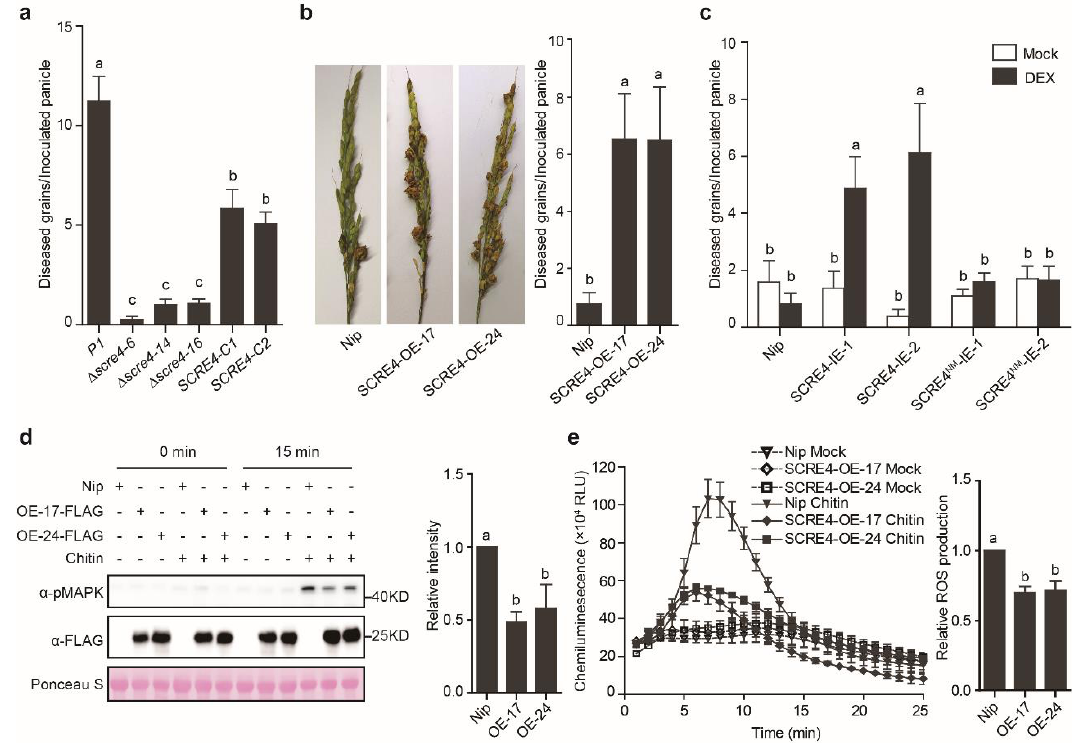
Figure 2. SCRE4 is an essential virulent factor in U. virens . ( a ) The average number of diseased grains per inoculated panicle. The U. virens wild − type (P1), scre4 knockout mutant and complemented strains ( SCRE4 − C1 and C2 ) were injection-inoculated into young panicles of the susceptible rice cultivar LYP9 ( n = 14, 15, 15, 15, 12, 13). ( b ) Disease symptoms and diseased grains on rice panicles of the wild − type (Nip), SCRE4 − OE − 17 and − 24 lines after inoculation of the U. virens isolate JS60 − 2 ( n = 12, 13, 10). Left images showed disease symptoms on the representative rice panicles after U. virens inoculation. ( c ) Diseased grains on U. virens − inoculated panicles of the wild − type (Nip), SCRE4 − IE and SCRE4 NM − IE lines. The wild − type and different transgenic lines were treated with 30 µM DEX and mock solution followed by injection inoculation with JS60 − 2 ( n = 12, 11, 8, 8, 8, 8, 10, 10, 10, 9). In panels ( a – c ), diseased grains were counted at 4 weeks after inoculation. The representative data from three independent experiments are shown as mean ± SE. Different letters ( a – c ) indicate significant differences in the average number of diseased grains on rice panicles after inoculation of different strains ( a ), on the panicles of the wild − type and SCRE4 − OE transgenic lines ( b ), and on the SCRE4 − IE panicles after DEX and mock treatments ( c ) ( p < 0.05, Duncan’s multiple range test) . ( d ) Chitin − triggered MAPK activation in the wild − type and SCRE4 − overexpressing transgenic lines. Total protein loading is indicated by Ponceau S staining. Right panel, the chitin − activated MAPK phosphorylation levels normalized to total proteins from three independent experiments are shown as mean ± SE ( n = 3). Band intensity was determined by densitometry using ImageJ. Different letters ( a vs. b ) indicate a significant difference in the MAPK phosphorylation level ( p < 0.05, Duncan’s multiple range test). ( e ) Chitin − triggered ROS burst in the wild − type and SCRE4 − overexpressing transgenic lines. Right panel, relative ROS production in Nipponbare and SCRE4 − overexpressing transgenic lines induced by chitin from three independent experiments are shown as mean ± SE. The total ROS levels were quantified by measurement of peak areas under the curve of ROS burst using GraphPad Prism5. Different letters (a vs. b) indicate a significant difference in the relative ROS level in the wild − type (Nip) and SCRE4 − overexpressing transgenic lines ( p < 0.05, Duncan’s multiple range test).